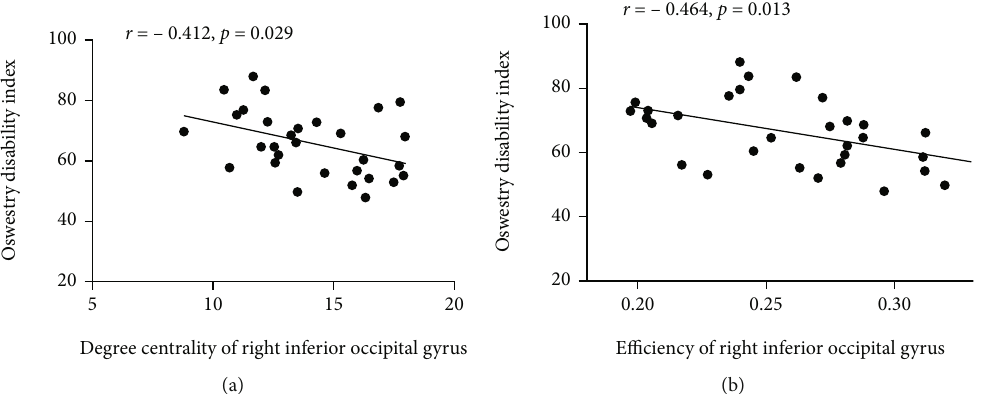
Figure 3: Correlation between Owestry Disability Index and degree centrality and e ffi ciency of right inferior occipital gyrus. Partial correlation analysis indicated positive correlation between Owestry Disability Index and degree centrality of right inferior occipital gyrus ( r =-0.412, p =0.029), as well as between Owestry Disability Index and e ffi ciency of right inferior occipital gyrus ( r =-0.464, p =0.013) while controlling the e ff ects of age and